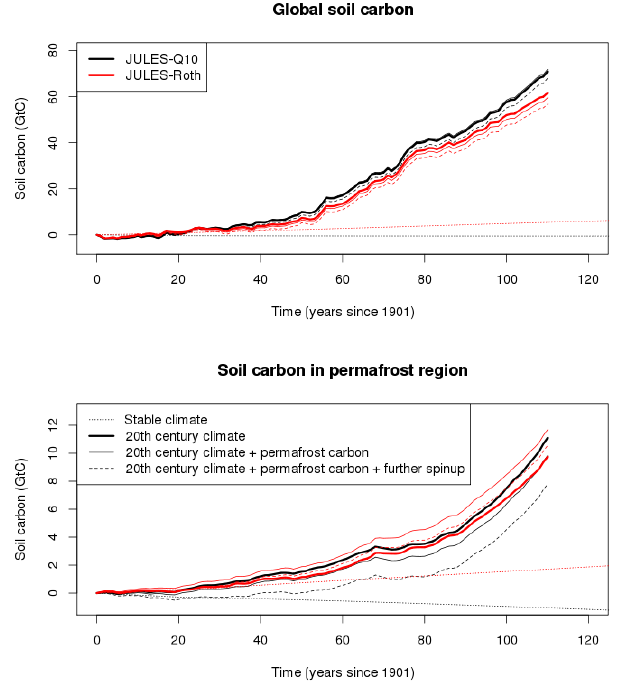
Figure 13. Change in soil carbon over 20th century with and with- out the observed permafrost carbon added, and with and without further